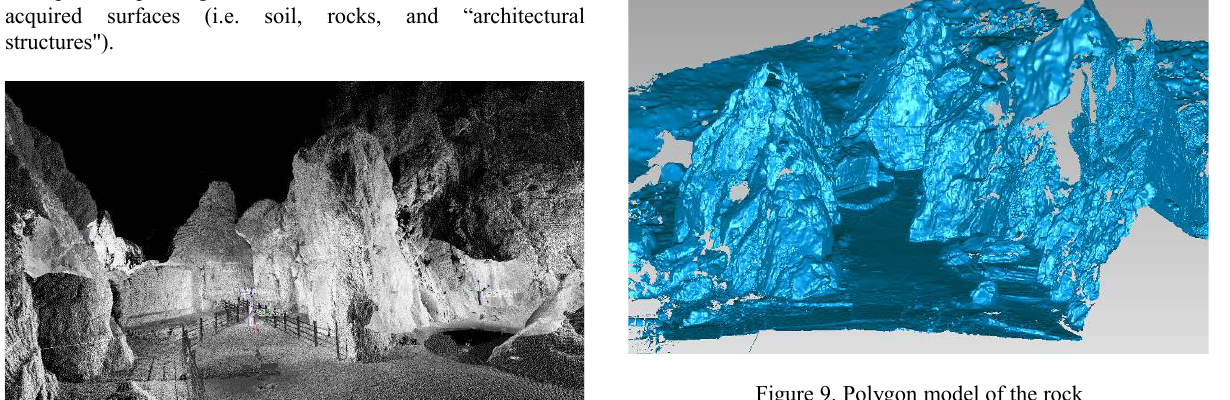
Figure 9. Polygon model of the